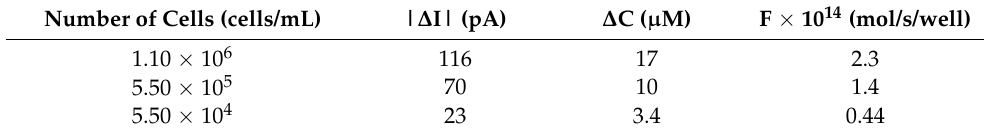
Figure 9. Comparison of the oxygen reduction currents measured via Z-scanning at three different cell concentrations. The red, blue, and green lines indicate the respiratory activity at a cell concentration of 1.10 × 10 6 cells/mL, 5.50 × 10 5 cells/ mL, and 5.50 × 10 4 cells/mL, respectively. I N : relative value of oxygen reduction current in bulk, which was set at 0 nA. Table 2. SECM-SCC with the milk cell chip. The respiration rate (F) is calculated using Equation (1). Number of Cells